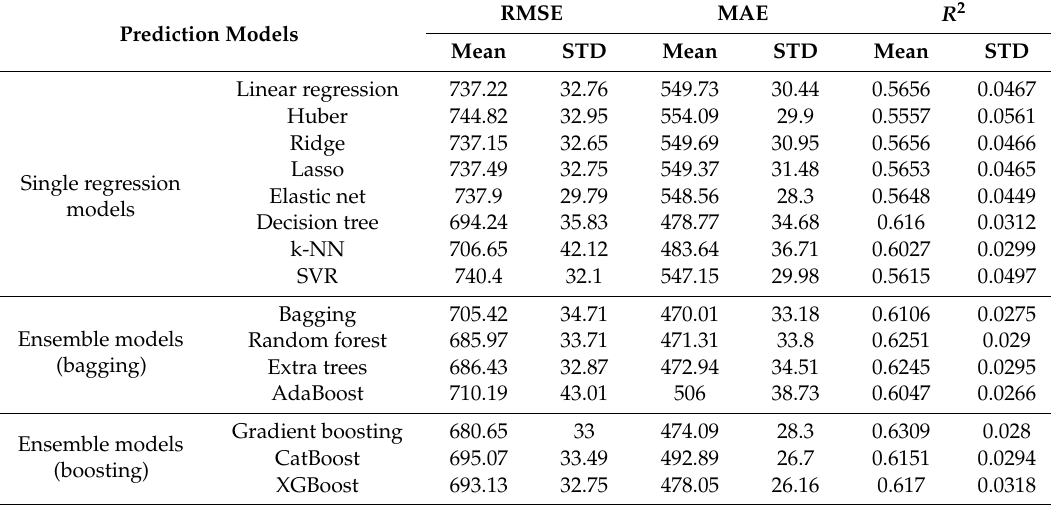
Table 5. Comparative statistics of prediction models based on observation weather information using 10-fold